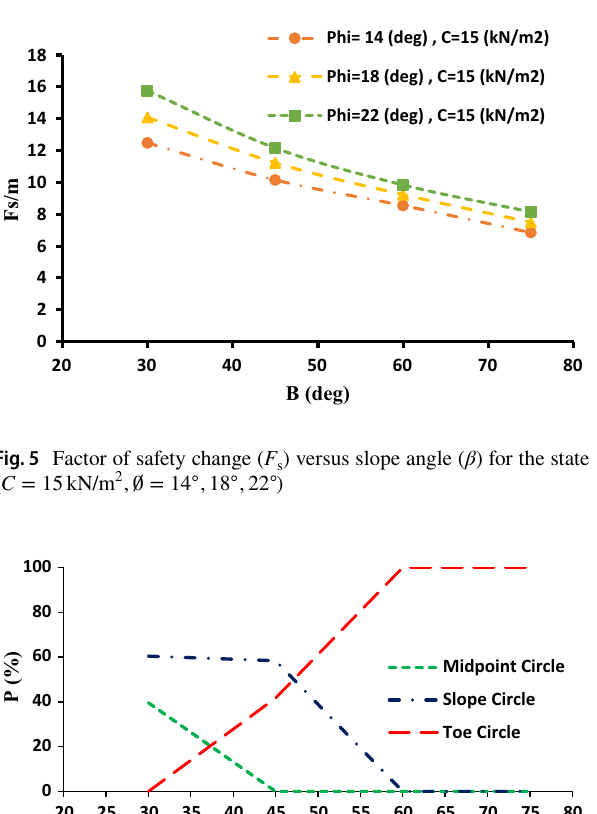
s ) versus slope angle ( )